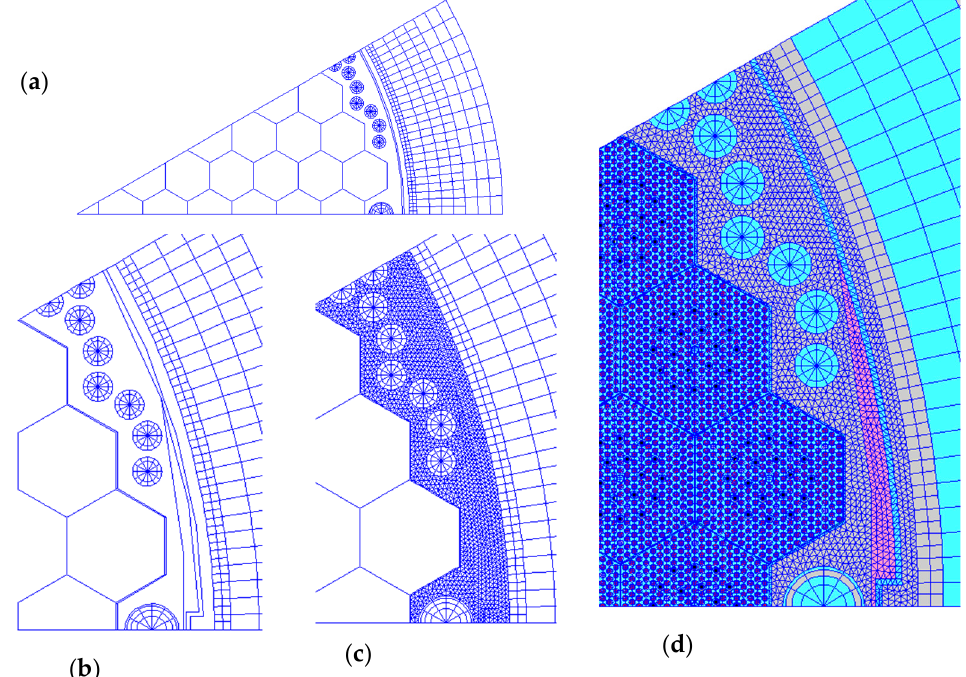
Figure 9. X2 VVER-1000 heavy reflector model by Silène. The model is first built by components in (a), the basket and the water gap next to the reflector are added by APIs in (b), a triangle mesh is applied in the reflector region in (c), yielding (d) as the final result after the FA import.